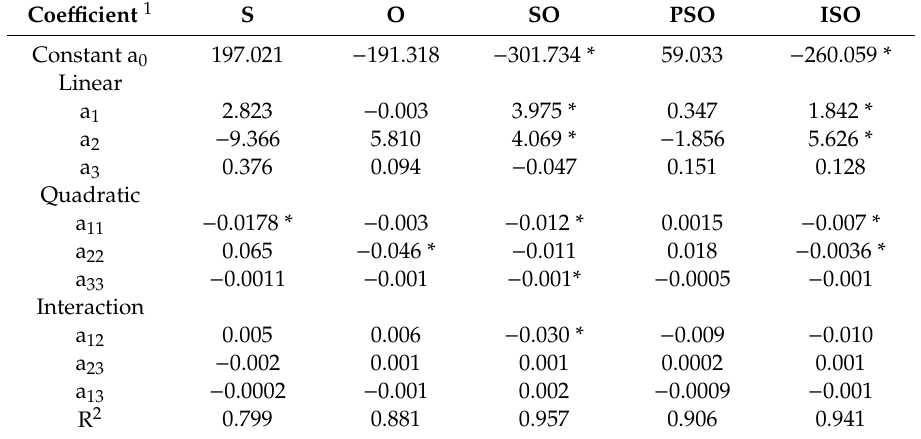
Table 2. Color ( ∆ E) coe ffi cients for tomato pre-treated with di ff erent osmotic solutions, (Equation (4)), based on experimental data of the design shown in Table